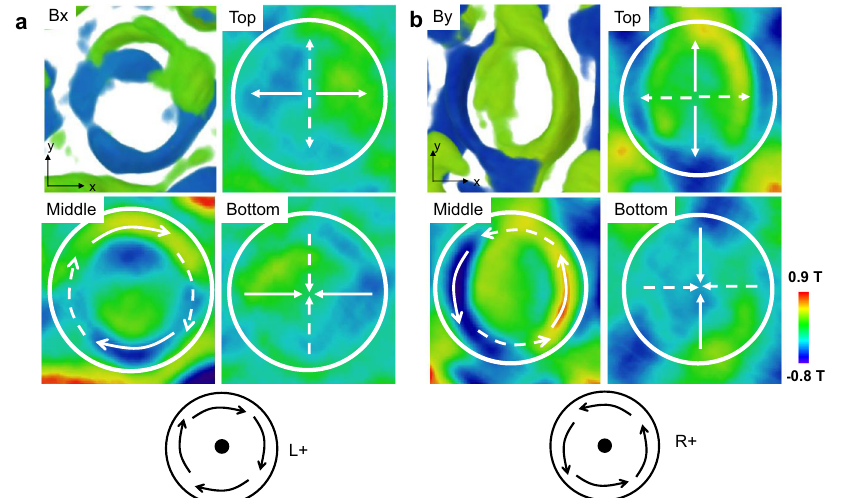
Fig.4|Themagneticspintransitionofbubble#5. TheB x ( a )andB y ( b )featuresin thetop,middle,andbottomx-ysections.Thesolidarrowsindicatethedirectionof the corresponding component, while the dashed arrows indicate the speculative direction of the orthogonal component based on prior knowledge of Bloch